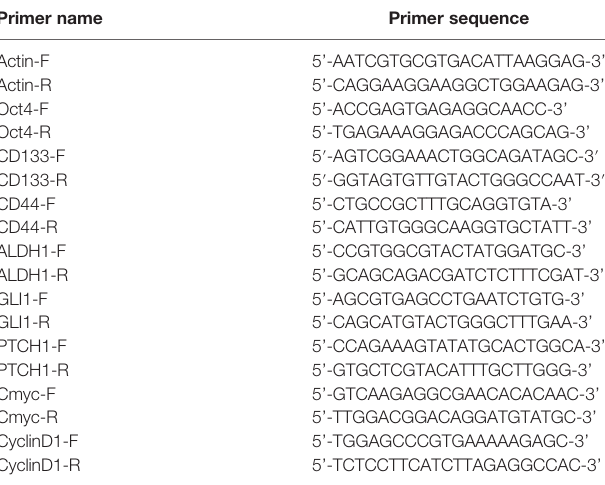
TABLE 1 | Sequence of primers in quantitative PCR analysis.